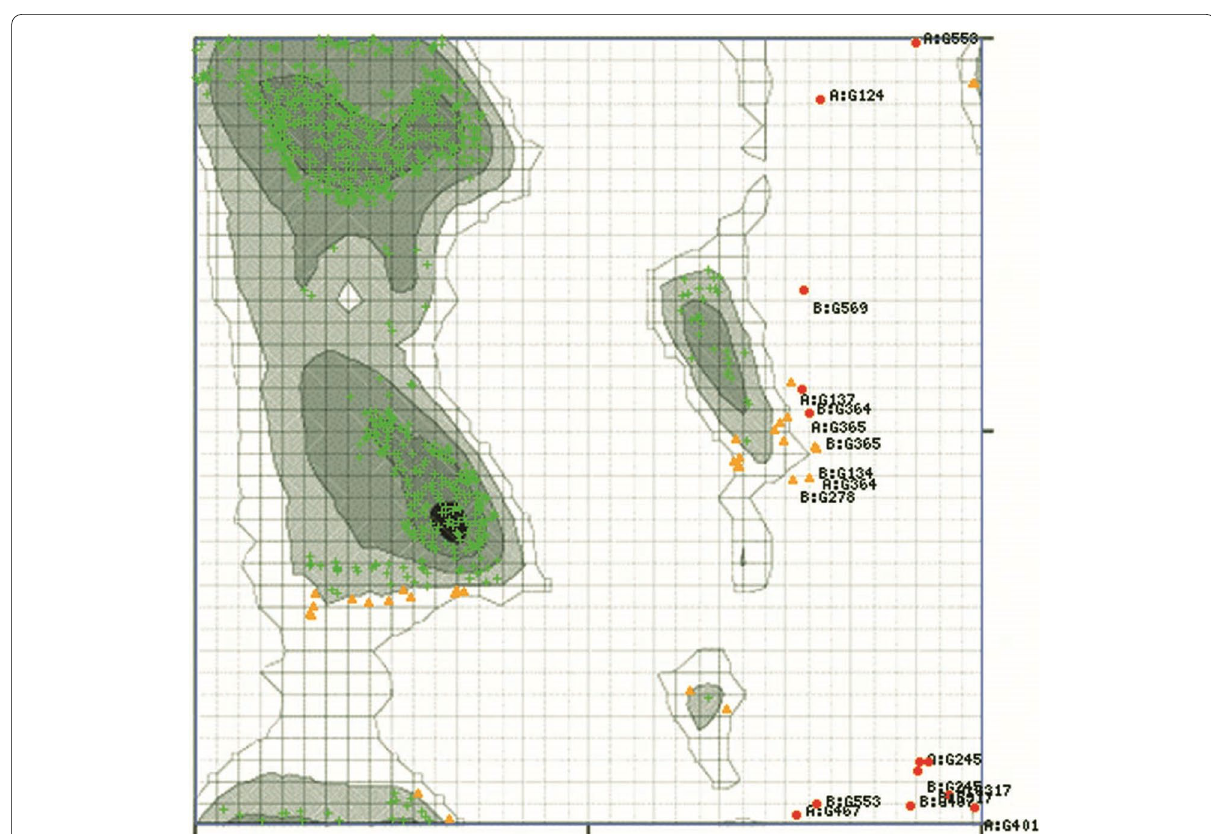
Fig. 5 The Ramachandran plot of the refine model (the software MolProbity: http:// kinem age. bioch em. duke.